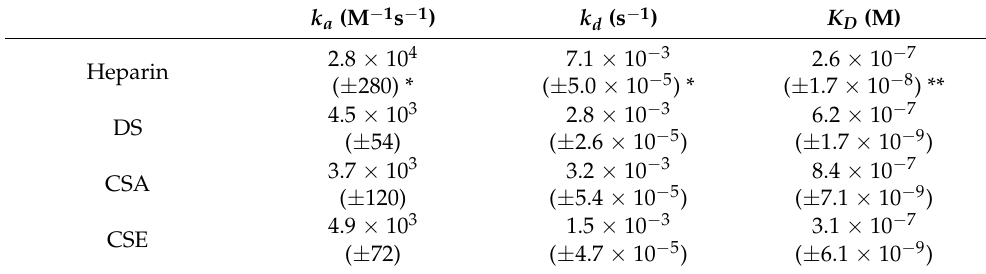
Table 2. Summary of kinetic data of MPXV A29 binding with heparin, DS, CSA, and CSE.